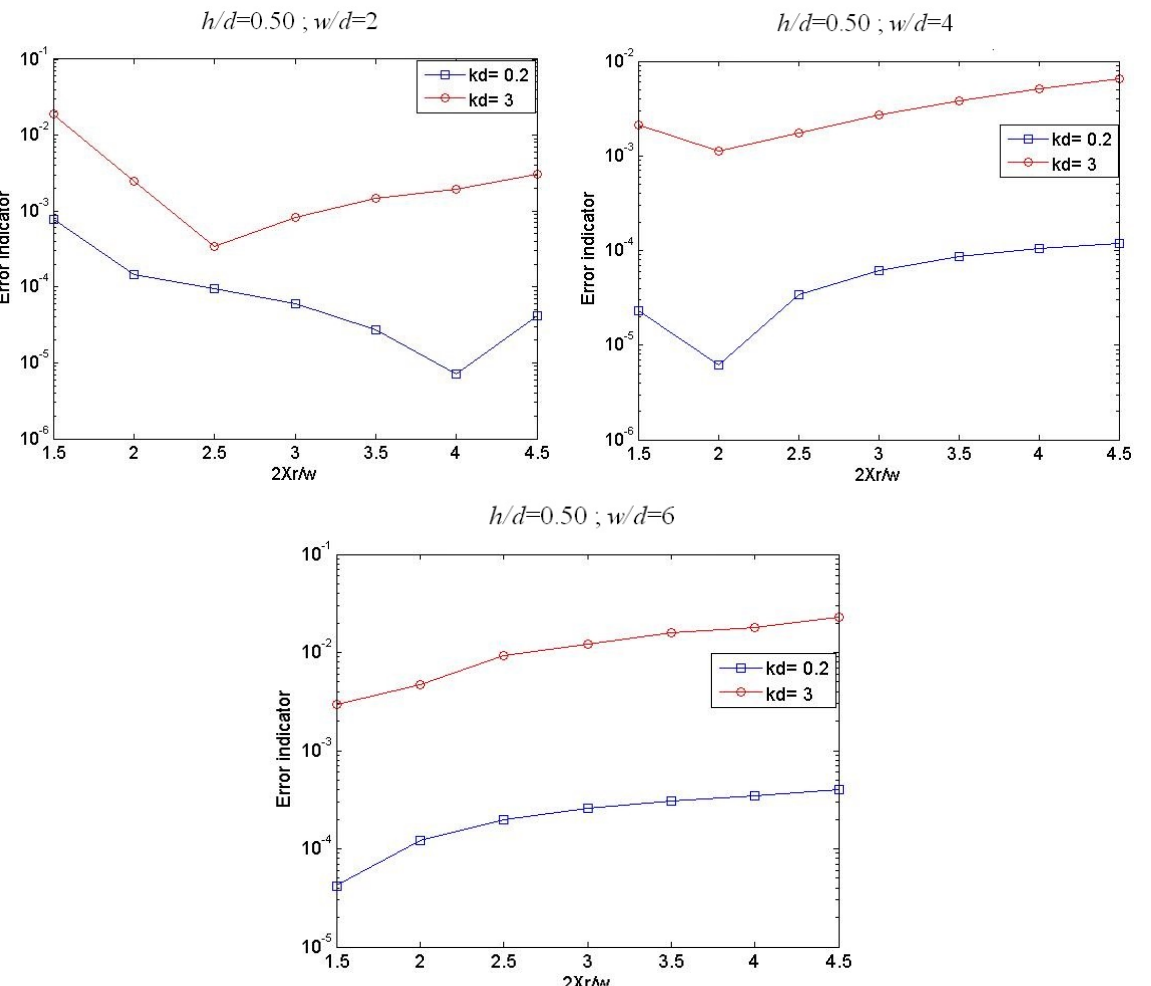
Figure 7. Error indicator versus the location of vertical fictitious boundaries for different relative lengths.